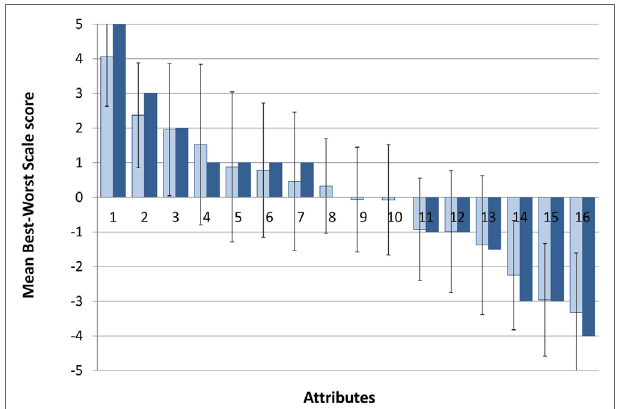
FigUre 2 | Aggregated Best–Worst Scale scores. Dark blue, median score; light blue, mean score; error bars represent standard deviation. Attributes on the x -axis are (1) long-term side effects, (2) effectiveness, (3) short-term side effects, (4) legality, (5) interactions with other substances, (6) reviews and experiences of others, (7) cost, (8) treatment, (9) degree of lifestyle change required, (10) specificity, (11) accessibility, (12) adherence required, (13) dosage, (14) formulation, (15) storage and preparation, and (16)